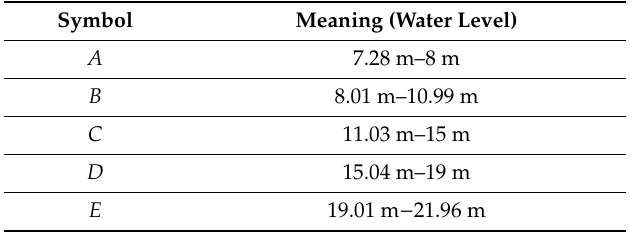
Table 5. The character sets and their meanings for the mean feature.